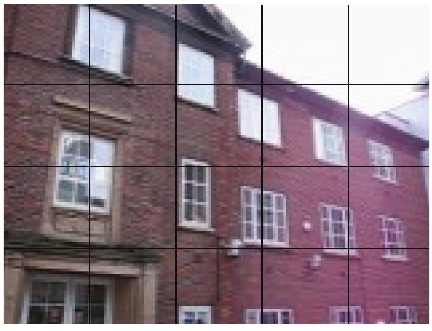
Figure 1: Four-by-five